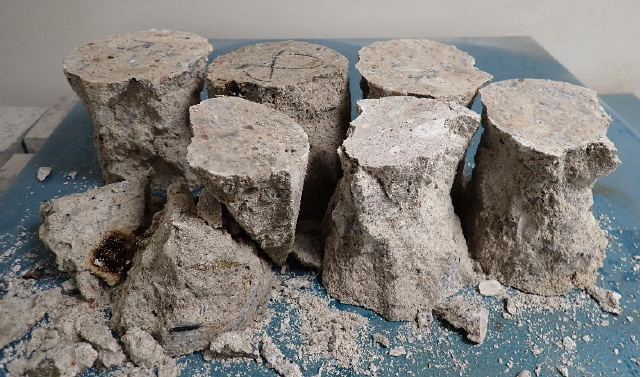
Figure 6. Parts of some concrete specimens after uniaxial compressive tests—views of the form of failure with visible organic inclusions and predominance of fine aggregates.